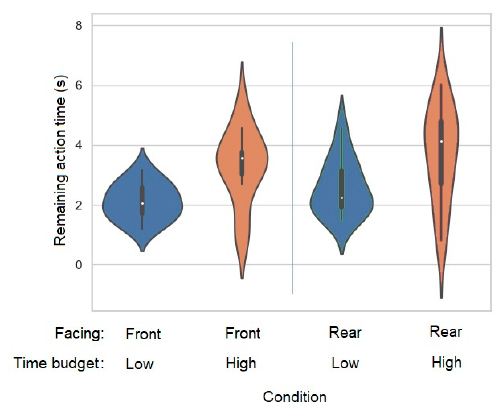
Figure 4. Remaining action time results from different conditions in violin plot. Median is shown by the white dot. Interquartile range is shown by the black bar. The range between the lower/upper adjacent values is shown by the black line. The violin shape shows the probability density smoothed by kernel density estimation. The plot was generated using the Seaborn library in Python.